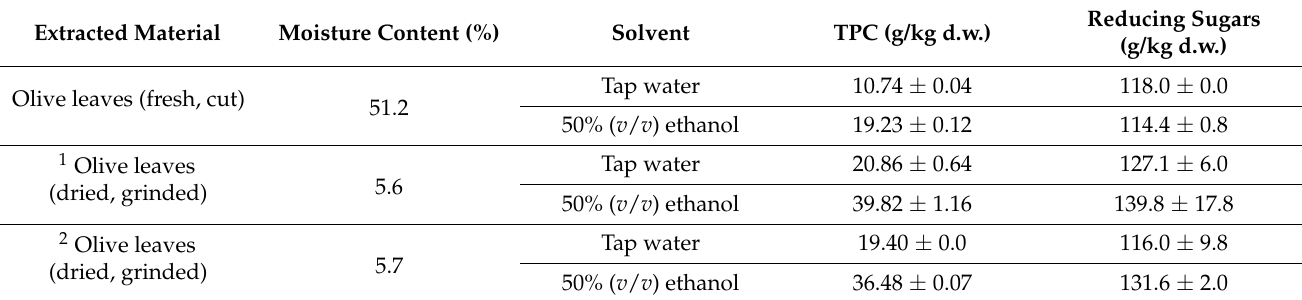
Table 1. Effect of drying and grinding on the extraction of phenolics and sugars and effect of two-month storage on the extractives of dried olive leaves.